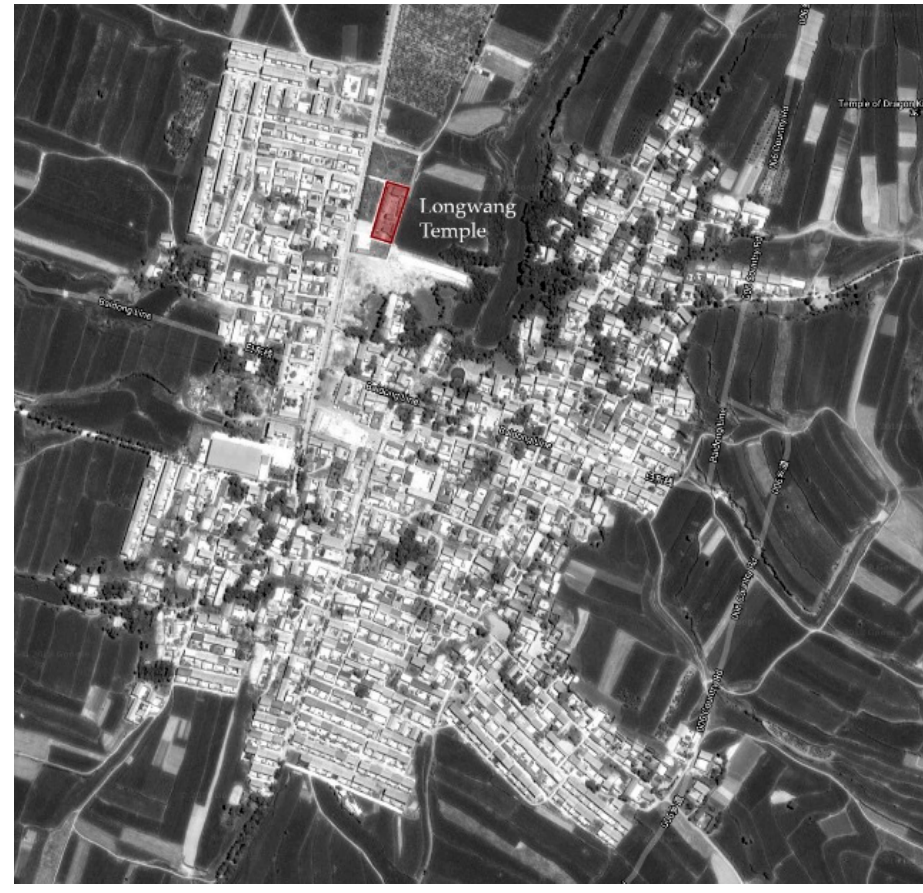
Figure 3. Map of Dongyi Village and Longwang Temple (base map: © Google Maps).